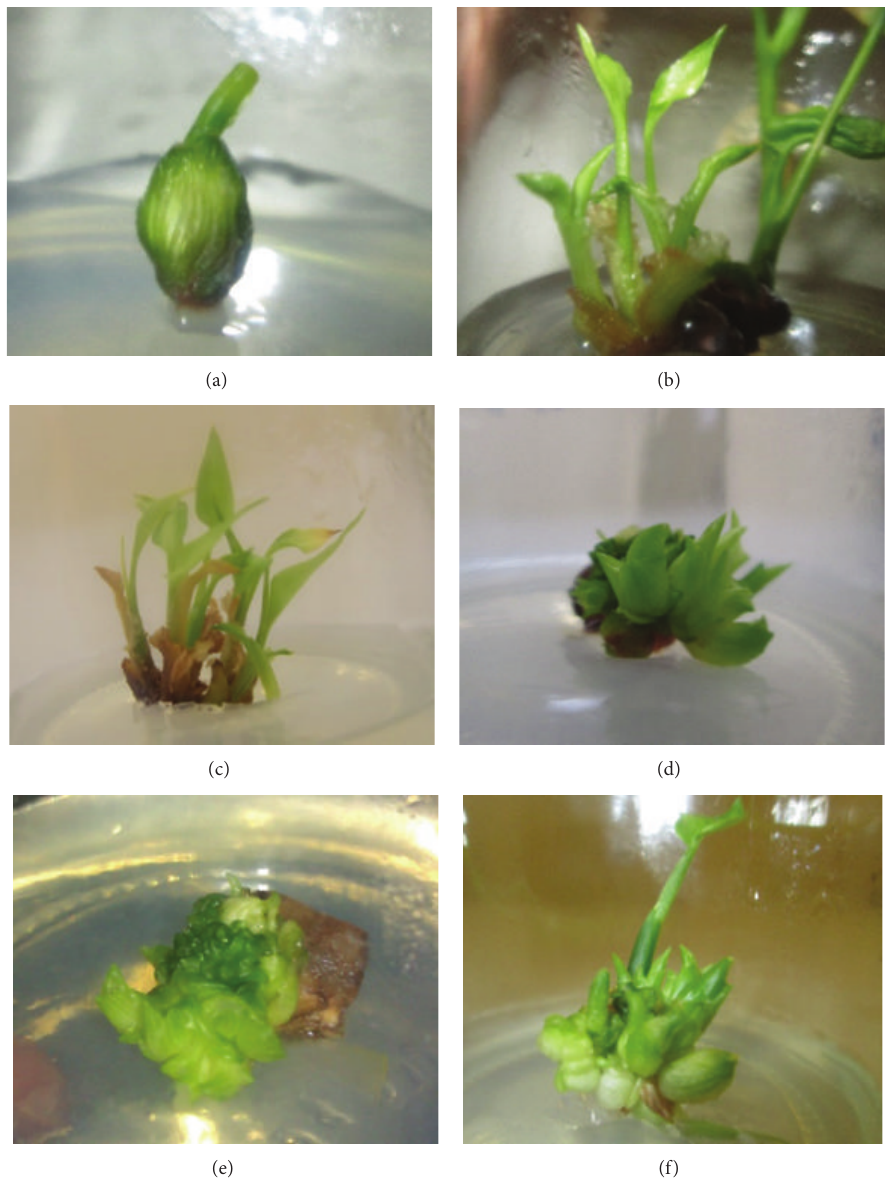
Figure 3: Effects of medium solidification and apex damage. (a) Swollenness of explant in media with 3 g/L plant agar. (b) Leaves show vitrification problem in media with 3 g/L plant agar, (c) regenerated shoots with necrotic leaves in media with 8g/L plant agar. (d), (e), and (f) Induction of microshoots through elimination of apical